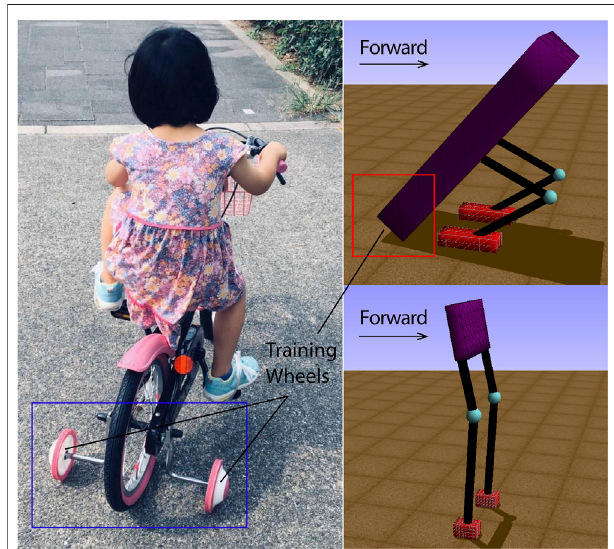
FIGURE 1 | The general idea of scaffolded learning can be exempli fi ed with a child on training wheels (the left fi gure) . The long body length of a biped creature can be adjusted to act as atripod withshorter legs (the upper right fi gure) , sacri fi cing speed to gain stability, while a longer leg and short body would be optimal bipedalism (the lower right fi gure)